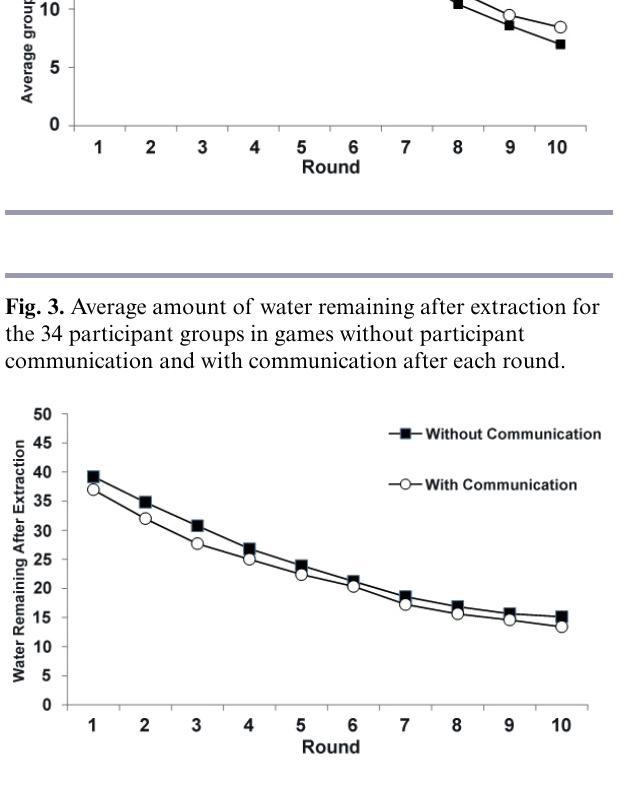
The groups earned between 97 and 160 units of income per game.